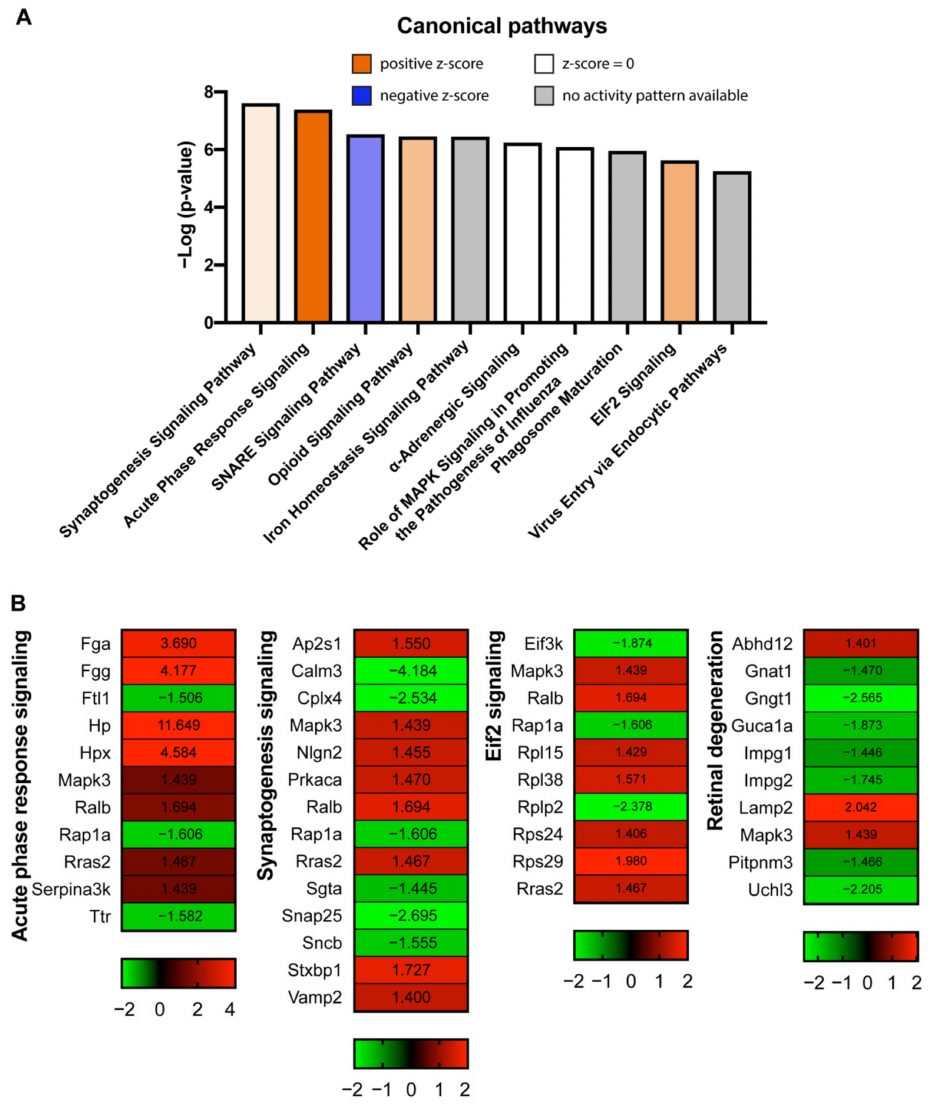
Figure 5. ( A ) The top 10 canonical pathways affected in the EIU model identified by IPA with − Log10 ( p -value) and z-score indicated. Blue bars: negative z-score; orange bars: positive z-score; grey bars: no activity pattern available; white bars: z-score = 0. The darker coloring of the bars represents the more significant z-scores. ( B ) The heatmaps of canonical signaling pathways, including acute phase response signaling, synaptogenesis signaling, eif2 signaling, and retinal degeneration-related molecules. The number on each column represents the fold change of